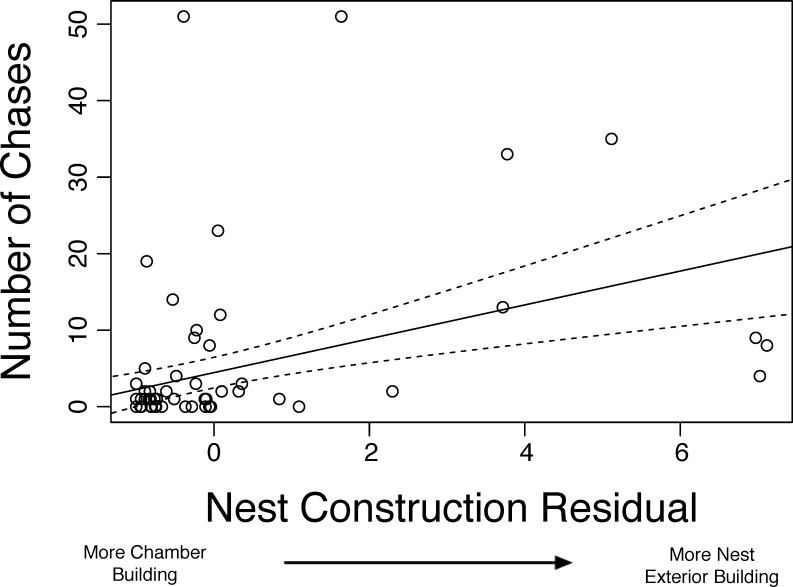
Positive association between the nest construction residual and the number of chases an individual performed.The nest construction residuals are generated from a linear model that predicts number of items inserted into nest thatch based on the number of items inserted into nest chambers. Positive residuals represent weavers that inserted more items into the nest thatch relative to the expectation from the regression. The solid line is the predicted line from the linear model while the dashed lines represent the 95% confidence interval around the line.